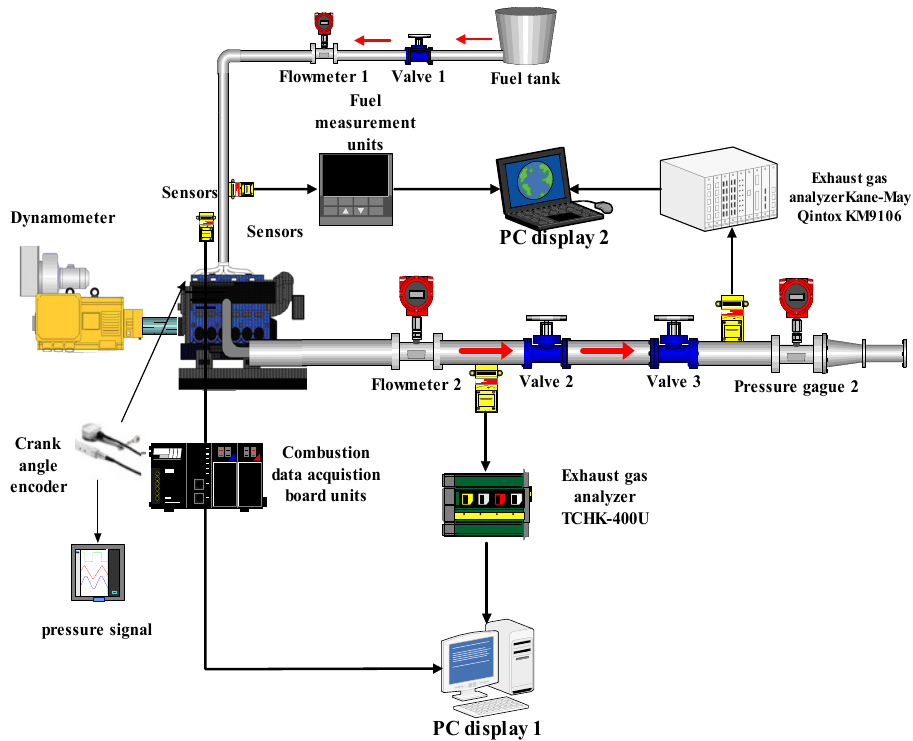
Figure 5. The schematic diagram of the experimental device.